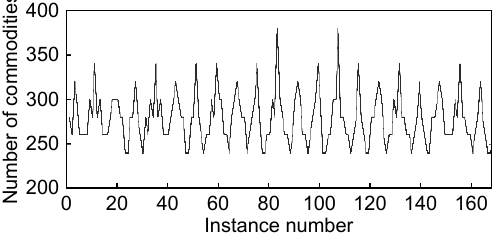
Fig. 7 Main parameters of the satellite constellation.